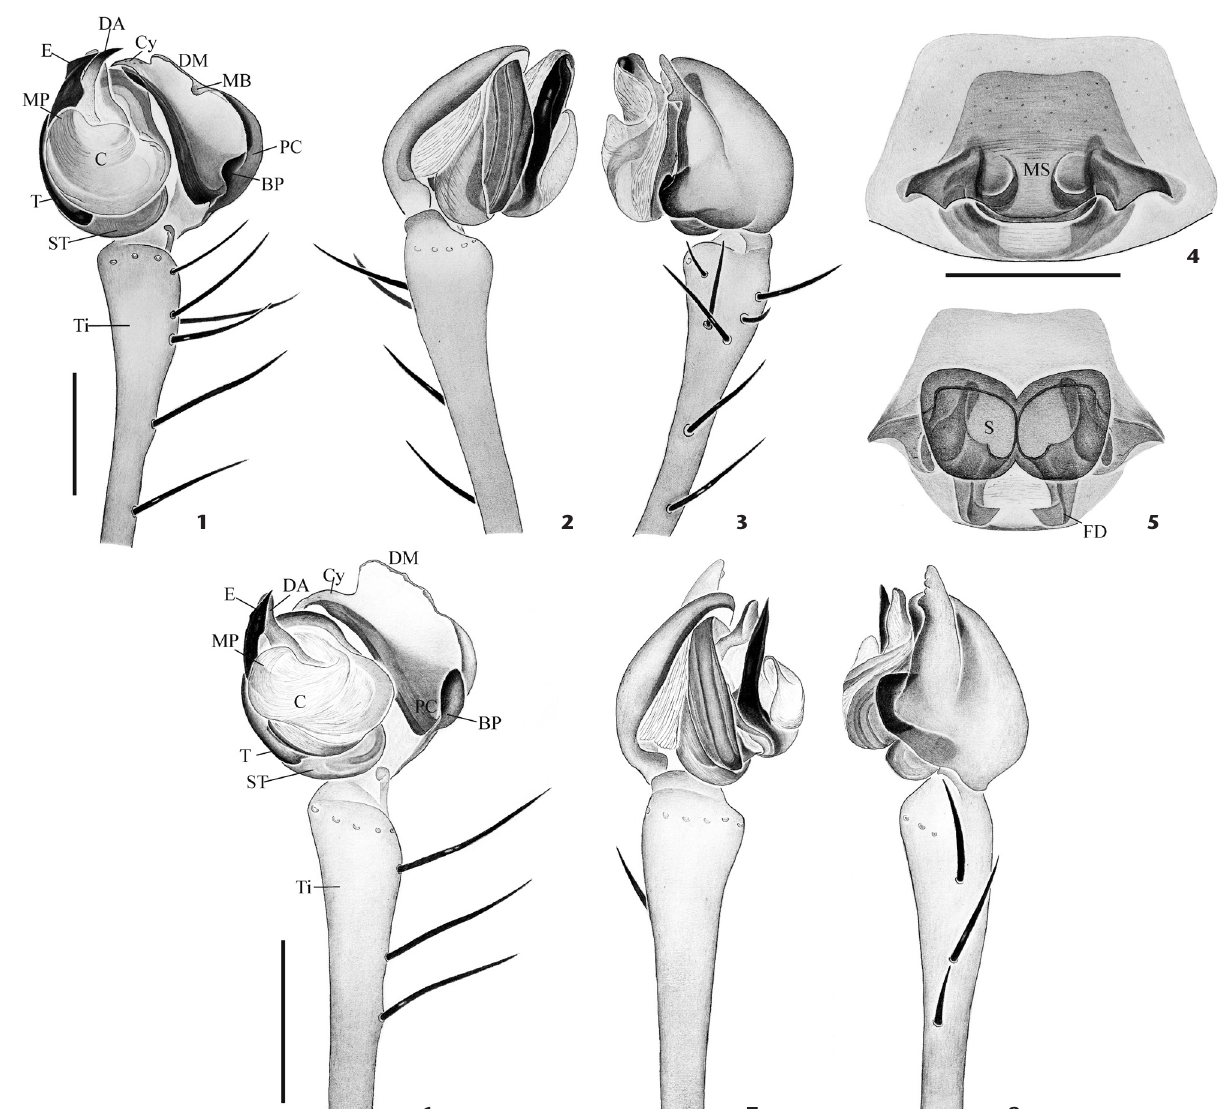
Figures 1-8. (1-5) Gelanor hoga sp. nov. : (1-3) male palp: (1) ventral, (2) prolateral, (3) retrolateral; (4-5) epigynum: (4) ventral, (5)